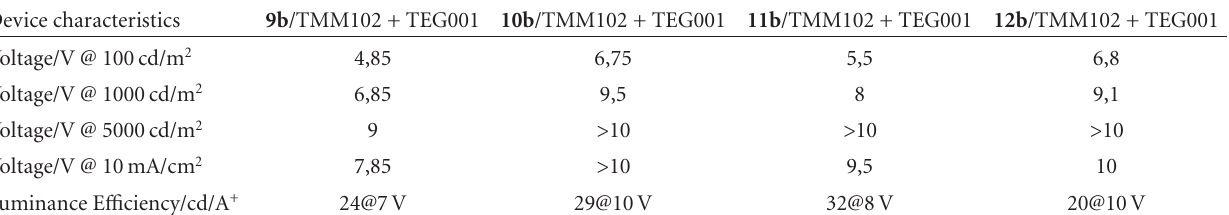
Table 5: Voltage and e ffi ciency of parasubstituted polymers 9b–12b . Device characteristics